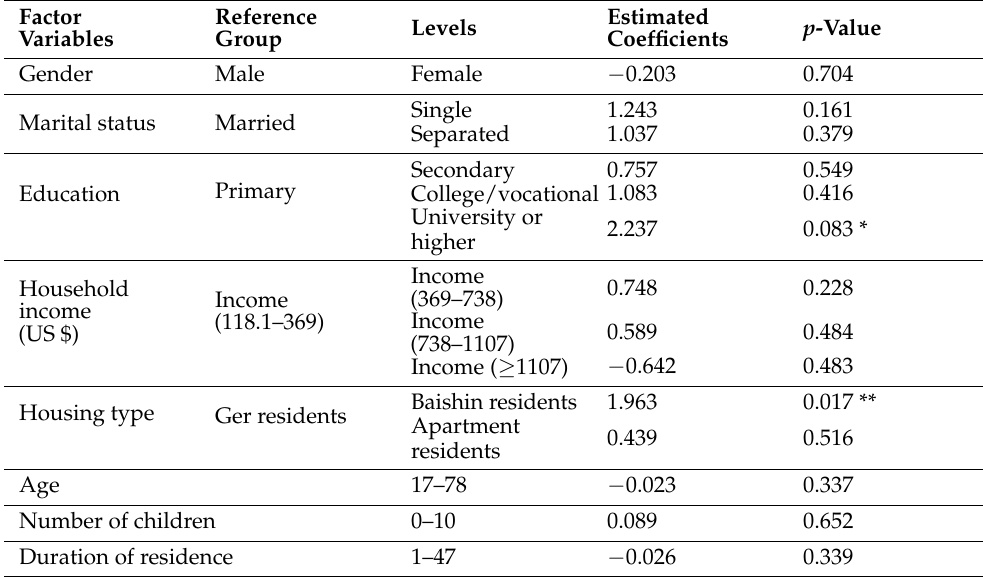
Table 2. Results of regression analysis regarding respondents’ willingness to participate (categorical and continuous variables).